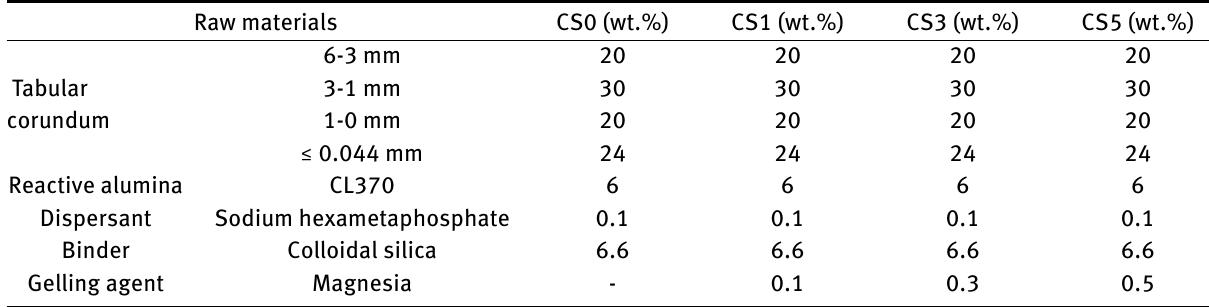
Table 1: Formulation of colloidal silica-bonded castables with and without magnesia. Raw materials CS0 (wt.%) CS1 (wt.%) CS3 (wt.%) CS5